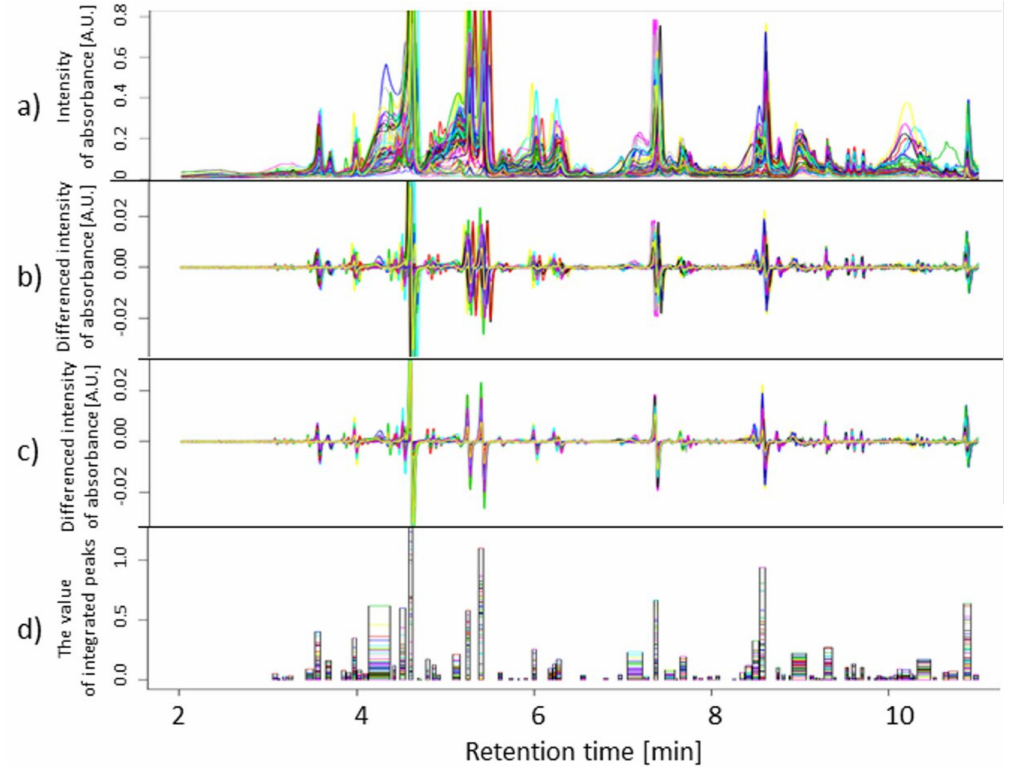
Figure 9. Preprocessing data from 62 chromatograms recorded at 330 nm for Maresi for all treatments and replications: ( a ) normalization by sample mass, ( b ) di ff erentiation, ( c ) correlation optimized warping (COW), ( d ) peak detection. The last plot shows the width of peaks and their value after integration for individual